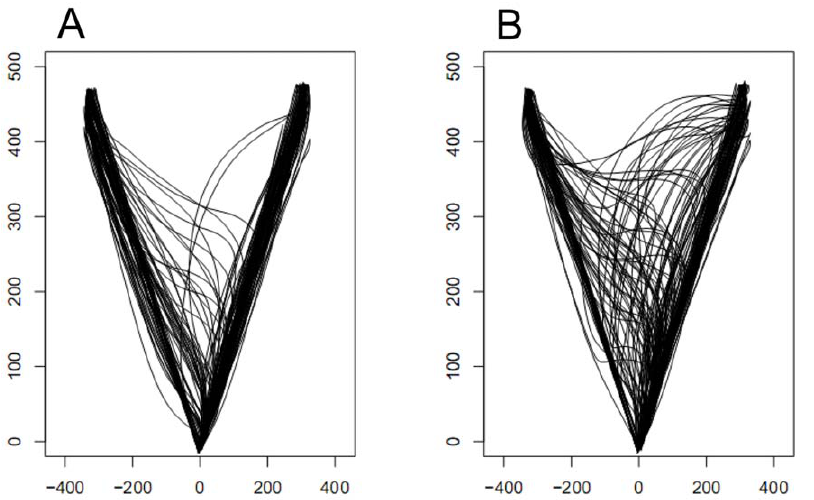
Figure 4. Sample data from one subject in Experiment 1. Panel A depicts reaching trajectories in the congruent condition; Panel B depicts reaching trajectories in the incongruent condition.